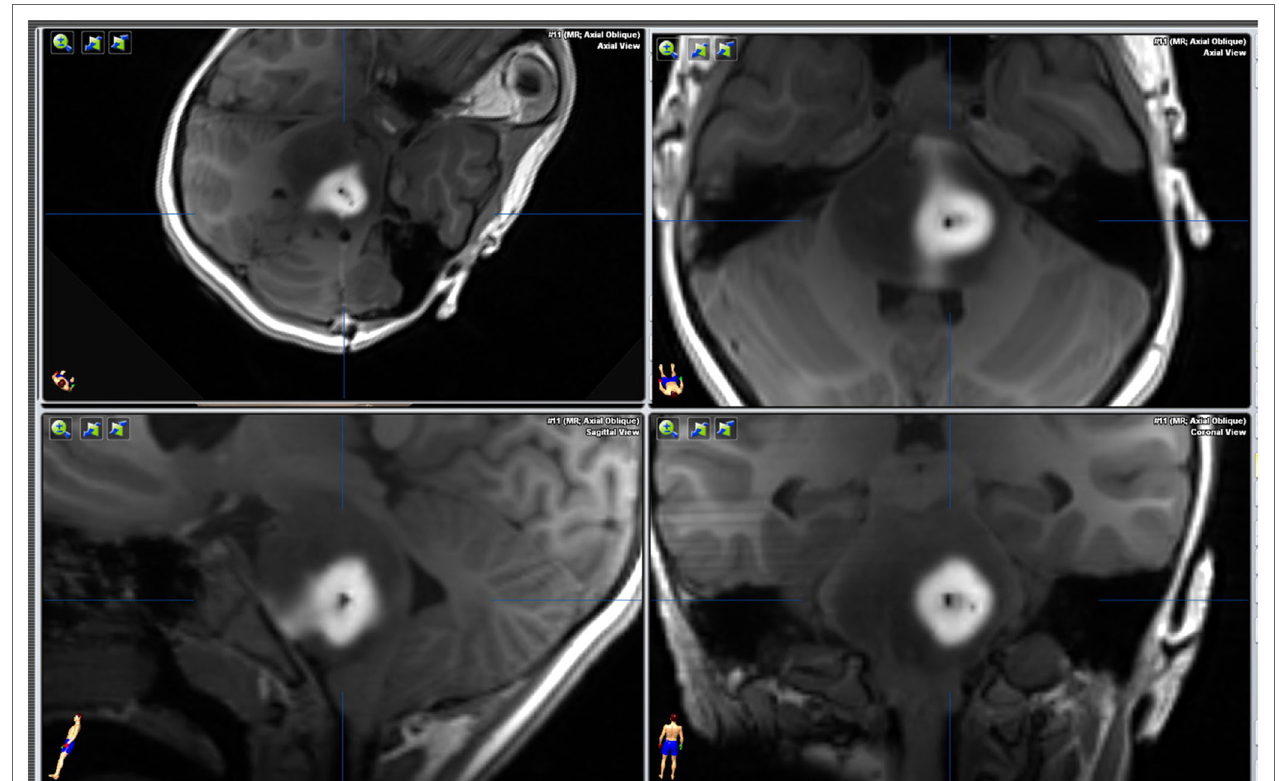
FIGURe 2 | Magnetic resonance imaging T1 GE 3D axial sequence without intravenous contrast, immediately after virus infusion. The intraparenchymal injection of gadolinium before infusing the virus with the MEMS cannula (this cannula has two independent channels) is pushed out from the tumor as the virus is infused from a second